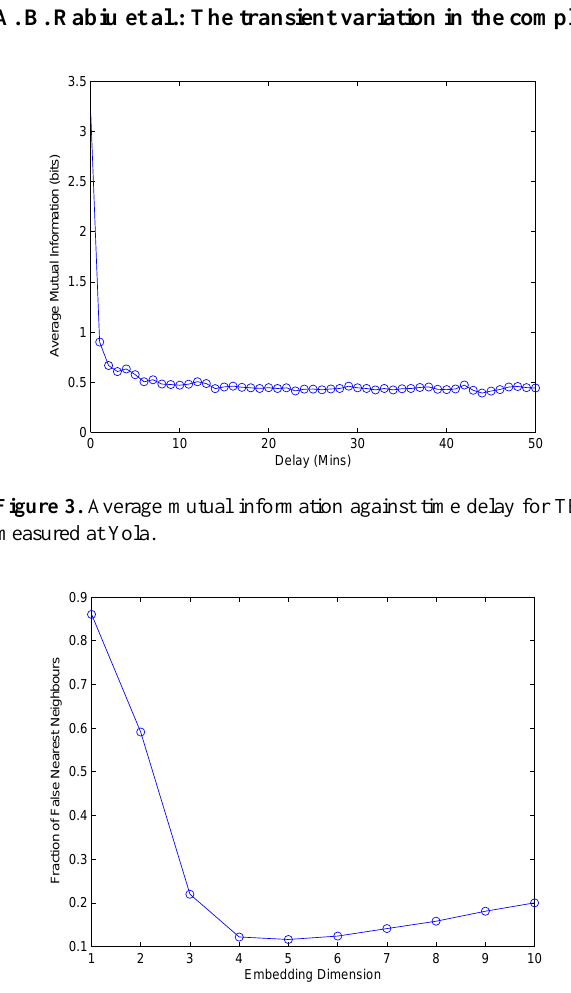
Figure 4. Fraction of false nearest neighbours against embedding dimension for TEC measured at Yola.